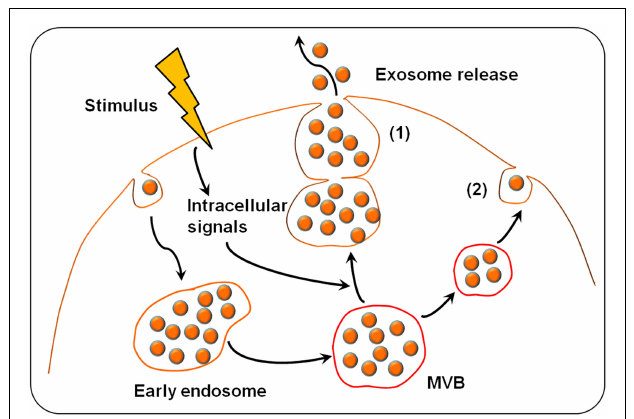
FIGURE 1 | Exosome biogenesis and release. Exosomes are derived from the multivesicular bodies (MVBs) which are known as late endosomes. Extracellular stimuli (e.g., microbial infection) can induce exosome formation and trigger exosome release.The exosomes can be released into the extracellular environment by either fusion of MVBs with the cell surface (1) or budding pathway (2). Fusion of MVBs with the plasma membrane surface involves the SNARE protein complex that brings the two membranes together. Budding exosomes are released from cytoplasm by budding of cell plasma membrane in response to cell